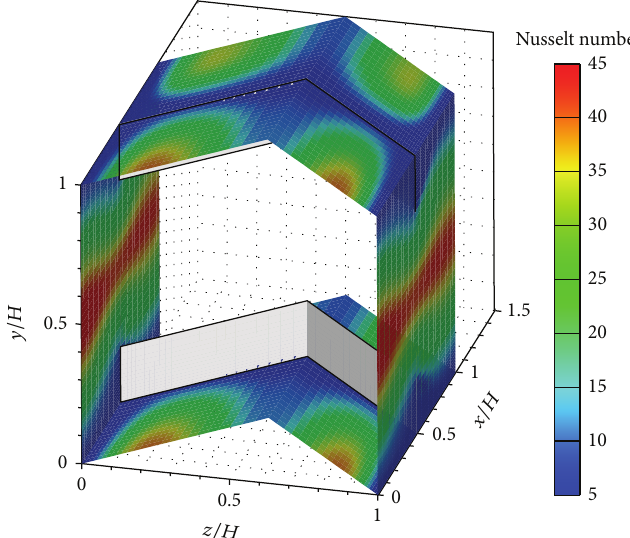
Figure 9: Contour plot of temperature in transverse plane for 𝛼 = 45 ∘ of V-Downstream rib at Re = 800 , BR = 0.20 , and PR = 1 .